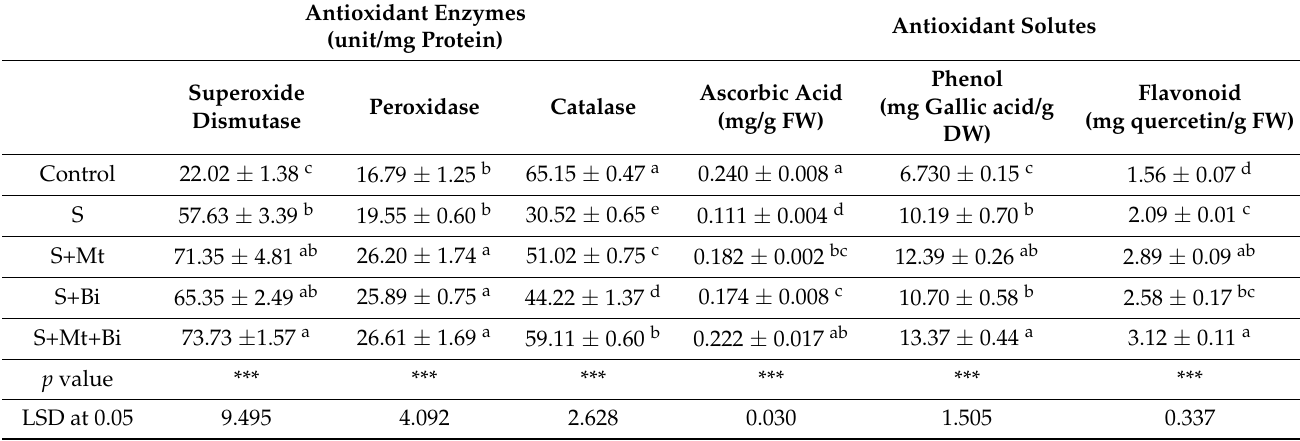
Table 4. The effect of melatonin (Mt) and/or biochar (Bi) supply on the antioxidant system of borage plants grown in a saline medium (S, 5000 ppm